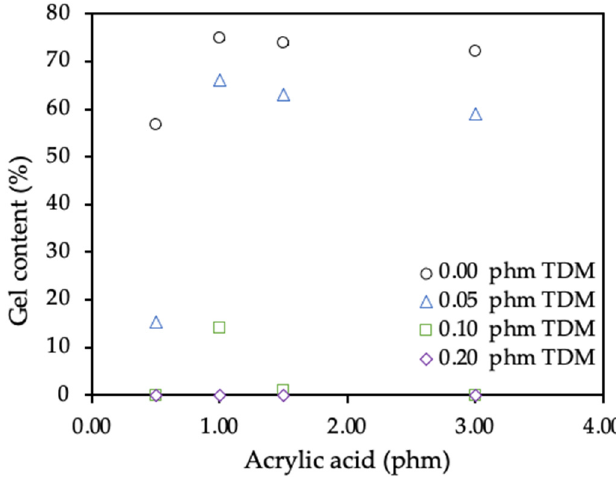
Figure 3. Effect of acrylic acid and tert-dodecyl mercaptan (TDM) levels in the gel content. Figure 3. E ff ect of acrylic acid and tert-dodecyl mercaptan (TDM) levels in the gel